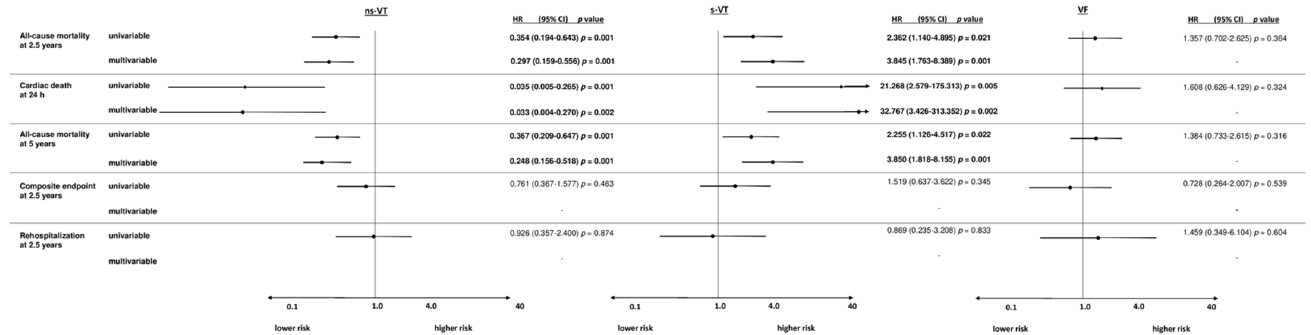
Figure 6. Forest plots demonstrating the uni- and multivariable hazard ratios (HR) with 95% confi- dence intervals (CI) for the primary endpoint all-cause mortality at 2.5 years, as well as for secondary endpoints all-cause mortality at 24 h, all-cause mortality at 5 years, the composite arrhythmic endpoint (i.e., recurrent ventricular tachyarrhythmias, appropriate ICD therapies) at 2.5 years and cardiac rehospitalization at 2.5 years in patients considered at lower risk. Multivariable models were adjusted for age, sex, diabetes, chronic kidney disease and COPD. HRs with corresponding 95% CI were calculated for the comparisons of patients with VF compared to s-VT, s-VT versus ns-VT and ns-VT versus s-VT and VF.